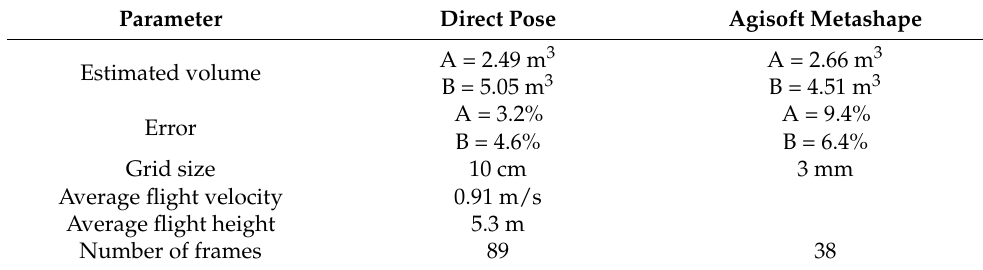
Figure 8. Hay bales reconstruction via direct positioning of depth frames. ( a ) Single hay bales and ( b ) adjacent hay bales. Table 2. Hay bales experiment, quantitative data.